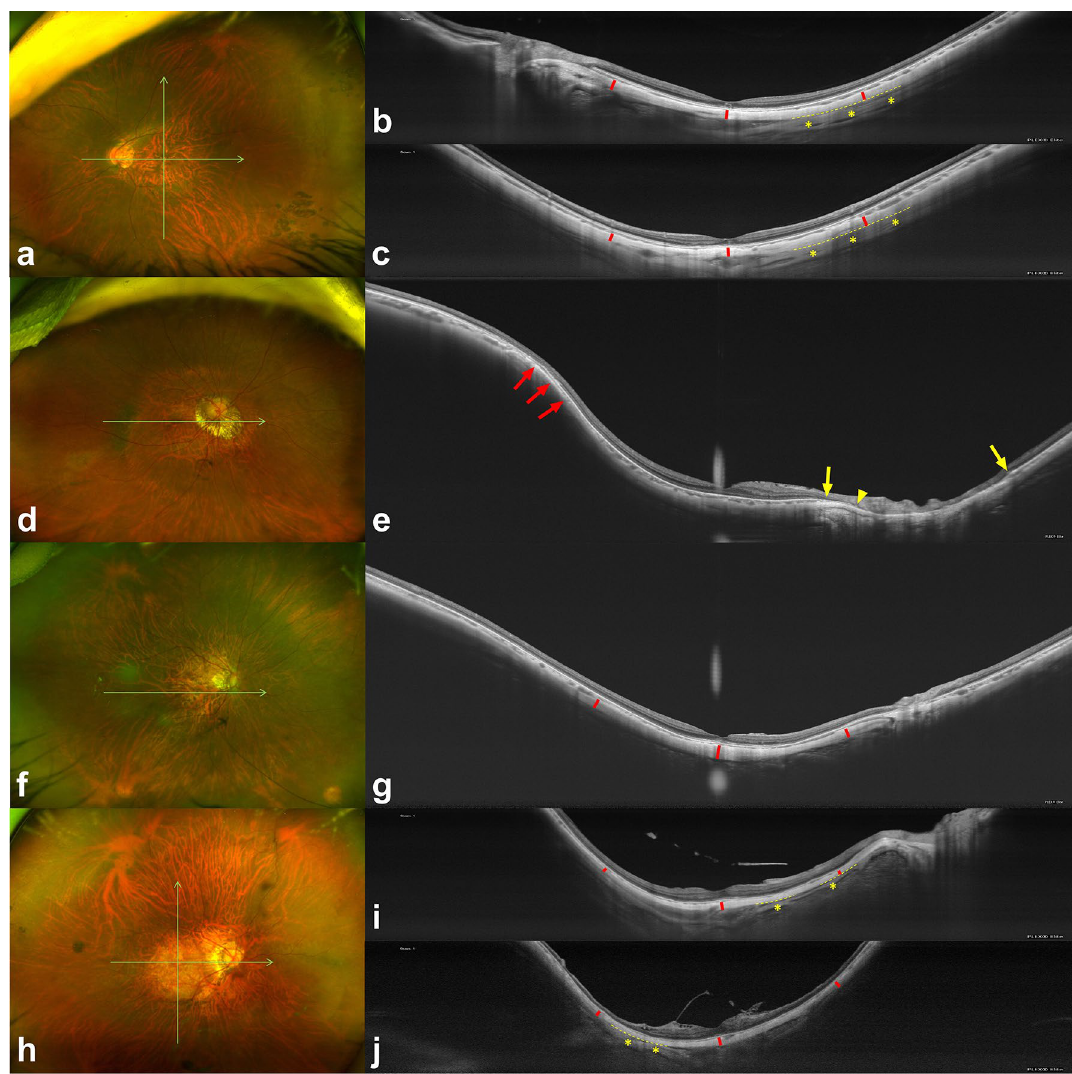
Figure 2. Images of highly myopic eyes with myopic maculopathy of category 1 (tessellated fundus) or 2 (diffuse chorioretinal atrophy). The green arrows represent the cross-section through which optical coherence tomography (OCT) scan was performed, and red bars represent scleral thicknesses at the fovea and at 3 mm from the fovea. In some images, the episcleral tissue appears as a uniform structure outside of the sclera with a slightly lower reflectivity (asterisks). Interfaces between the sclera and episcleral tissue are outlined with dashed lines. All OCT images were shown on a 1:1 µm scale. ( a – c ) A 24-year-old woman with tessellated fundus. The axial length was 30.63 mm and the best-corrected visual acuity (BCVA) was 20/32. The choroidal and scleral thicknesses at the foveal, superior, inferior, temporal, and nasal regions were 13, 122, 71, 81, 49 µm and 214, 234, 193, 205, 249 µm, respectively. ( d , e ) A 78-year-old woman with a mild peripapillary diffuse chorioretinal atrophy temporal to the disc. Axial length was 29.86 mm and BCVA was 20/25. Choroidal thickness at the foveal, temporal, and nasal regions was 55, 92, and 42 µm, respectively, but the posterior scleral border was not visible at any measurement point. An inward protrusion of the sclera and thinning of the choroid are observed at the edge of the staphyloma (red arrows). Note the margin of retinal pigment epithelium defects (yellow arrows) and end of the Bruch membrane (arrowhead). ( f , g ) A 63-year-old woman with peripapillary diffuse chorioretinal atrophy. Axial length was 30.07 mm and BCVA was 20/20. Choroidal and scleral thicknesses at the foveal, temporal, and nasal regions were 20, 51, 17 µm and 290, 211, 203 µm, respectively. ( h–j ) A 49-year- old woman with macular diffuse chorioretinal atrophy. Axial length was 34.55 mm and BCVA was 20/125. The choroidal and scleral thicknesses at the foveal, superior, inferior, temporal, and nasal regions were 19, 11, 12, 18, 14 µm and 197, 168, 143, 115, 104 µm,